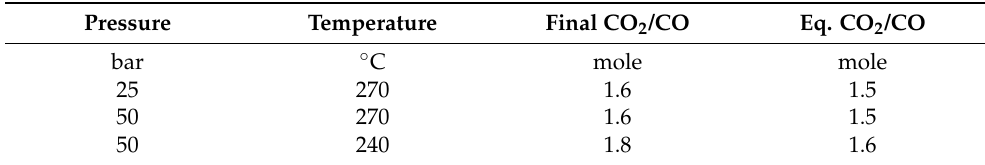
Table 3. CO 2 conversion and outlet CO 2 /CO ratio obtained with the CZA_30 catalysts at different reaction conditions at 15,000 h − 1 . Initial CO 2 /CO mole ratio equal to 1.9. The CO 2 /CO ratios at the equilibrium are indicated for